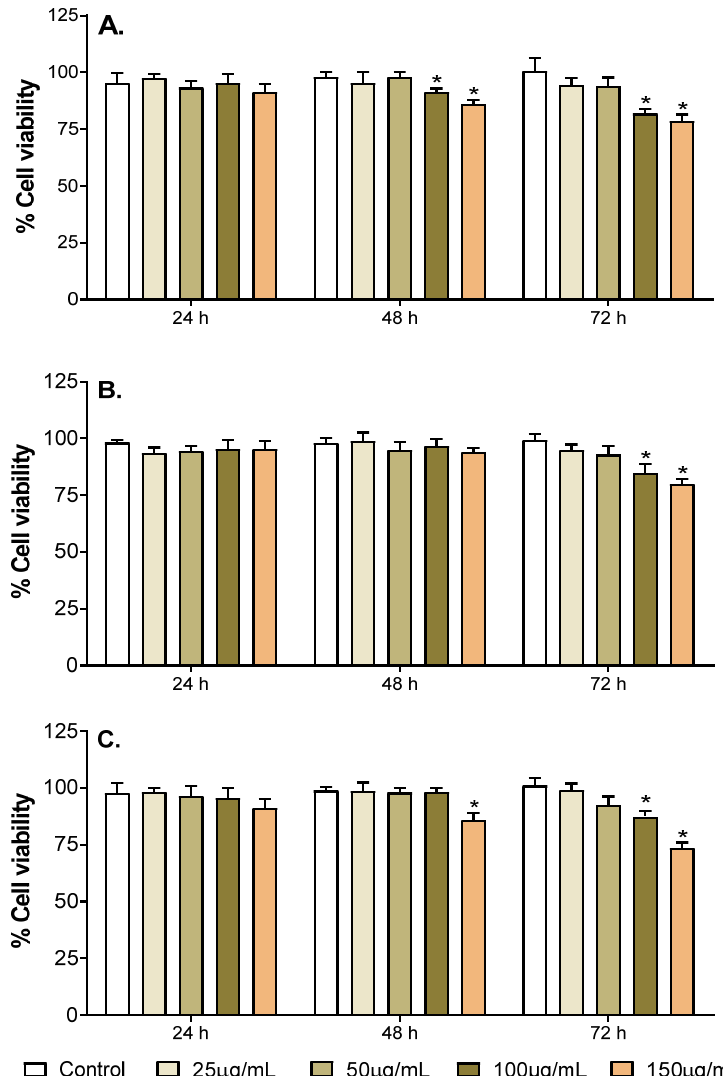
Figure 1. Percentage of cell viability when treating PC12 cells with different concentrations (25, 50, 100 and 150 µg/mL) of ( A ) M. indica ‘Kaew’, ( B ) M. indica ‘Namdokmai’, and ( C ) P. guajava ‘Kimju’ extracts at different incubating time periods (24, 48 and 72 h). Control: no exposure to fruit extracts (untreated control); * significance at p < 0.05 compared with untreated cells using two-way analysis of variance (ANOVA) followed by Tukey’s multiple comparisons test.